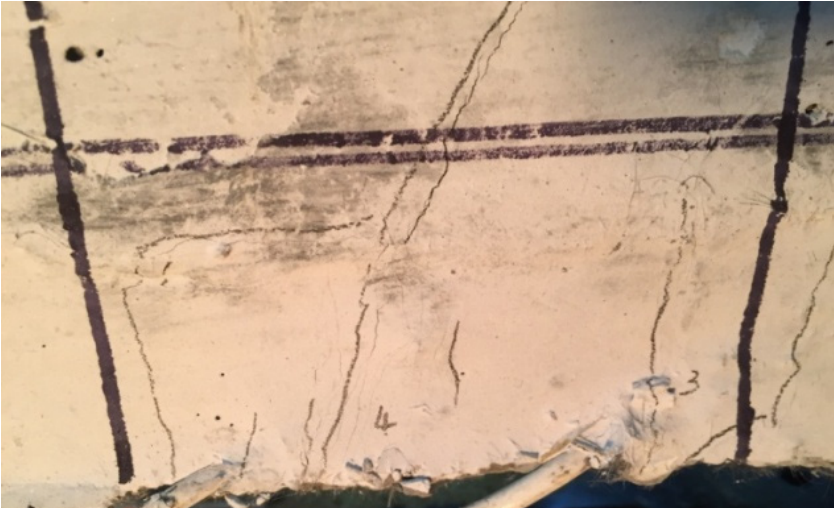
Figure 9. The crack distribution of SJ-3.